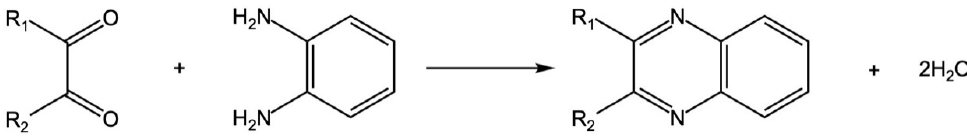
Figure 1. The reaction equation of OPD and α -DCs. Figure 8. 2,3-dihydroxypropanal underwent reverse aldol condensation and oxidation reaction to produce GO. 3 (cid:13) GO can be generated through reverse aldol condensation in C3-C4 and oxidation